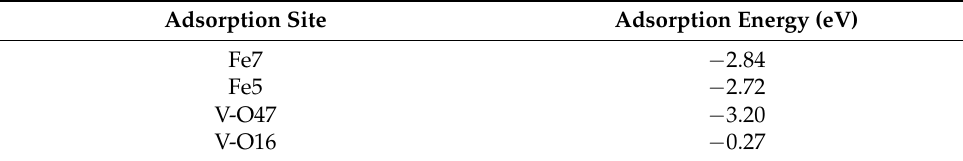
Table 4. HCl adsorption energy on FeV 2 O 4